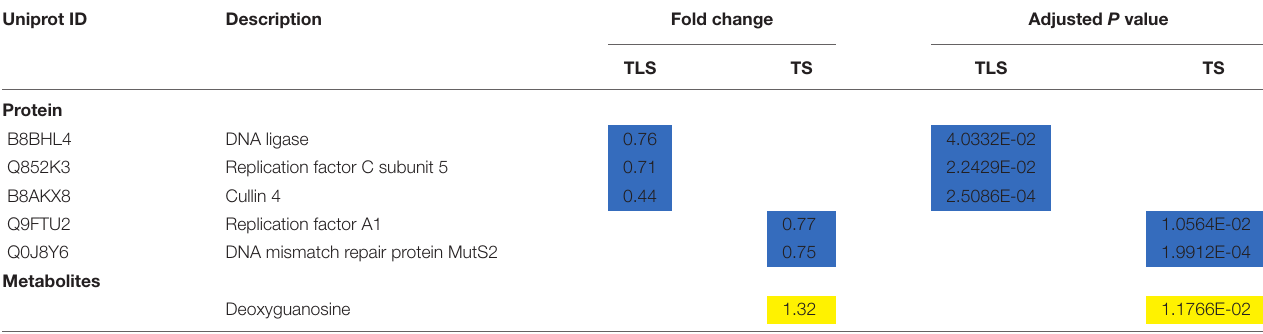
TABLE 4 | Differentially expressed proteins and metabolites related to DNA damage. Uniprot